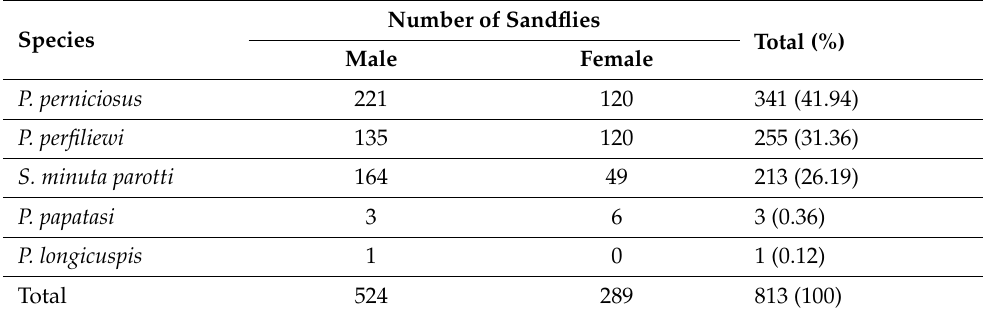
Table 1. Abundance of sandflies collected by CDC light traps in the exposure site, 2020. Number of Sandflies Species